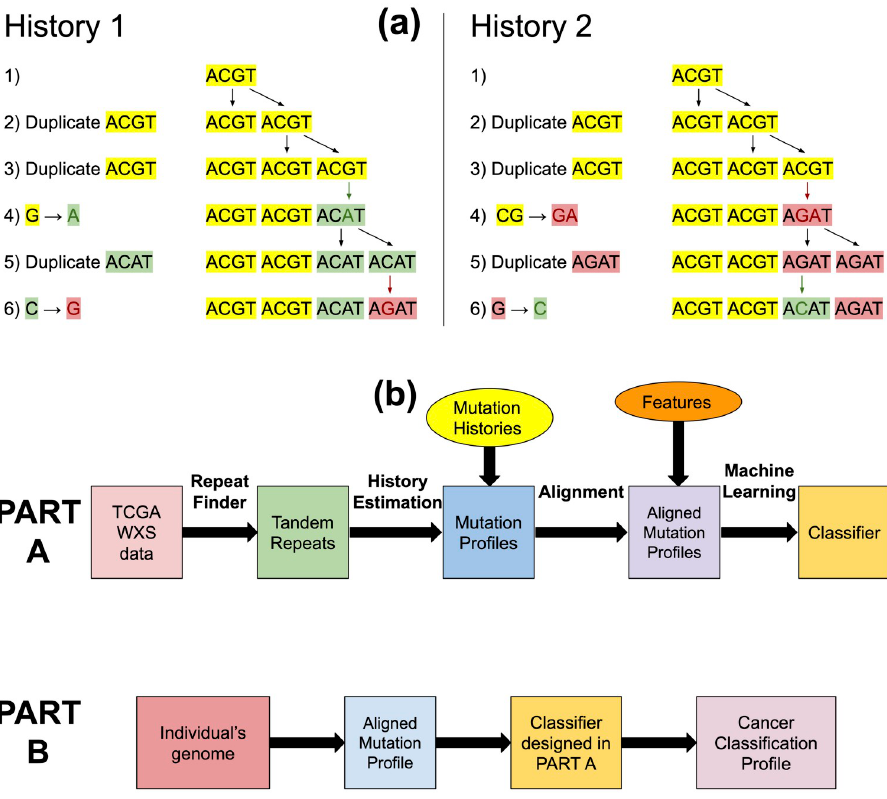
Fig 1. Pipeline for using mutation history for cancer classification. (a) Two different mutation histories for the tandem repeat region ACGTACGTACATAGAT with pattern length 4 and repeat region length 16. In History 1, only 2 point mutations were needed (marked with green and red respectively). In History 2, 3 point mutations were needed: 1 marked with green and 2 marked with red. In our approach, we would consider History 1 to be more likely as it involves lesser number of point mutations. Therefore, for this tandem repeat region we have that m = 2 and d = 4. (b) The workflow of our algorithm. In Part A a classifier is trained based on the mutation profiles generated from the blood-derived DNA of cancerous individuals. This part in only performed once per training set. In Part B, the resulting classifier is applied over a given genome to assess an individual’s inclination of developing different